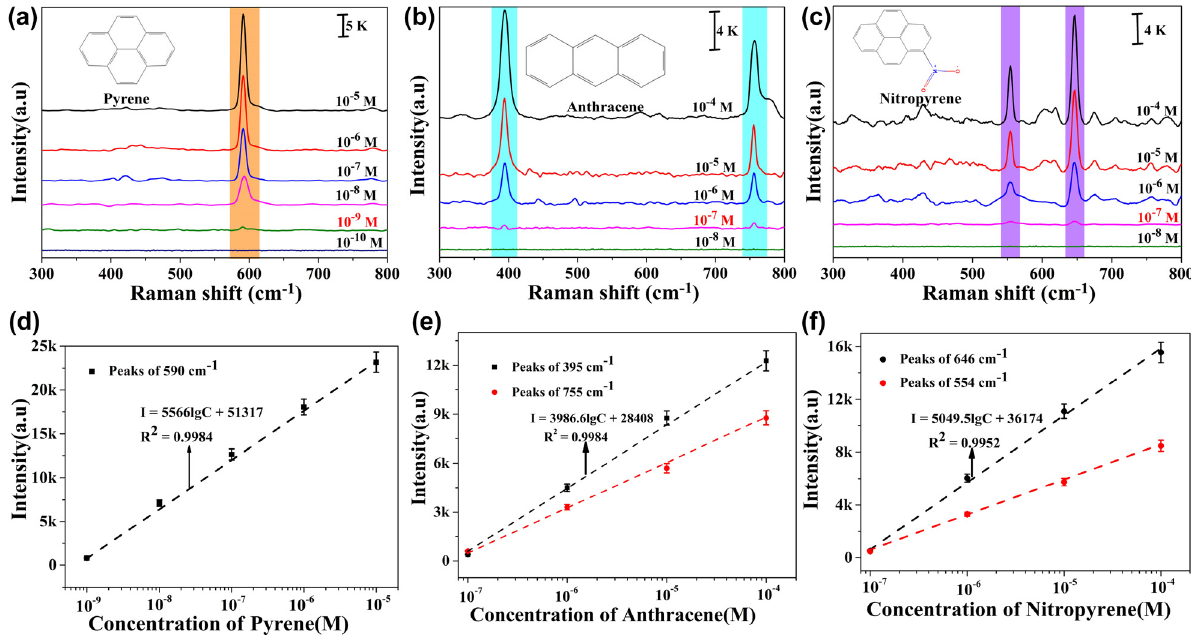
Figure 6: Double laser-boosted liquid-NIR-SERS spectra of (a) pyrene, (b) anthracene, and (c) nitropyrene at different concentrations, in the presence of as-prepared Au/Ag NUs. The insets show the structures of the corresponding probe molecules. The quantitative analyses: (d) the variation of Raman peak intensity at 590 cm − 1 as a function of pyrene concentration, (e) the variations of Raman peak intensities at 395 cm − 1 and755cm − 1 asafunctionofanthraceneconcentration,and(f)thevariationsofRamanpeakintensitiesat646cm − 1 and554cm − 1 asafunction of nitropyrene concentration, (each error bar indicates the standard deviation of 10 different